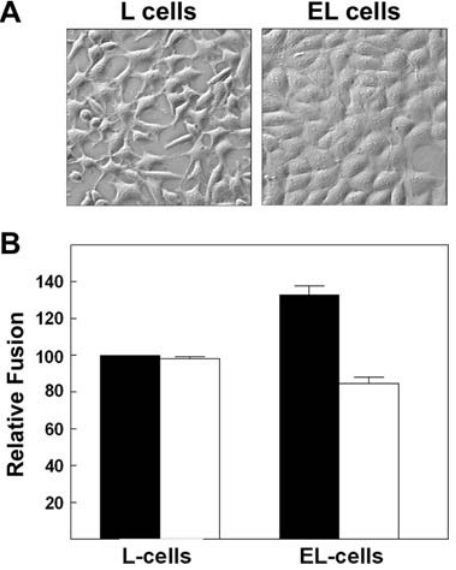
Figure 6. Ectopic cadherin expression enhances p14-mediated fusion. (A) Phase contrast microscopy (400 6 mag.) of L and EL cells. (B) L and EL cells were transfected with p14, cultured under normal (black bars) or low (white bars) calcium conditions, and the extent of syncytia formation in Giemsa-stained monolayers was quantified at 26 h post- transfection by syncytial indexing. Data is presented as the extent of fusion relative to L cells under normal calcium conditions. Values represent the mean 6 S.E. (n=3). The average number of syncytial nuclei per field in the L cells under normal calcium levels (i.e. the 100% level) was